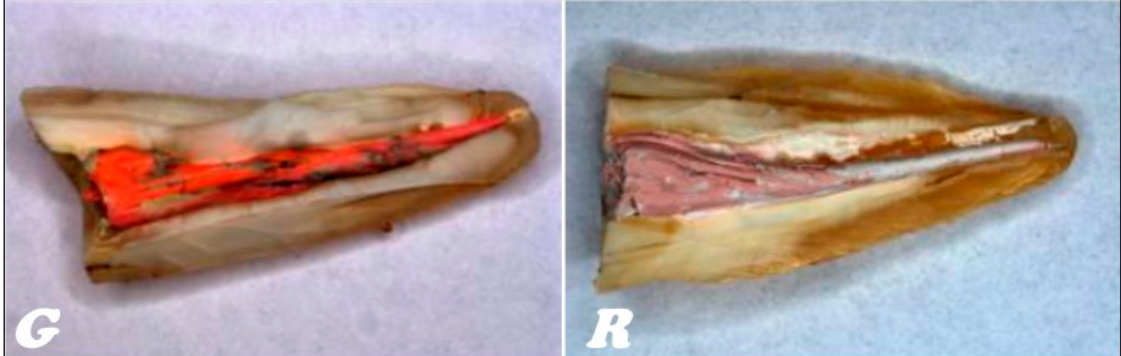
Figure 16. Longitudinal fracture of the tooth root filled by cold lateral condensation with material based on gutta-percha and sealant ( G ) and resilon with sealant ( R ); LCM.